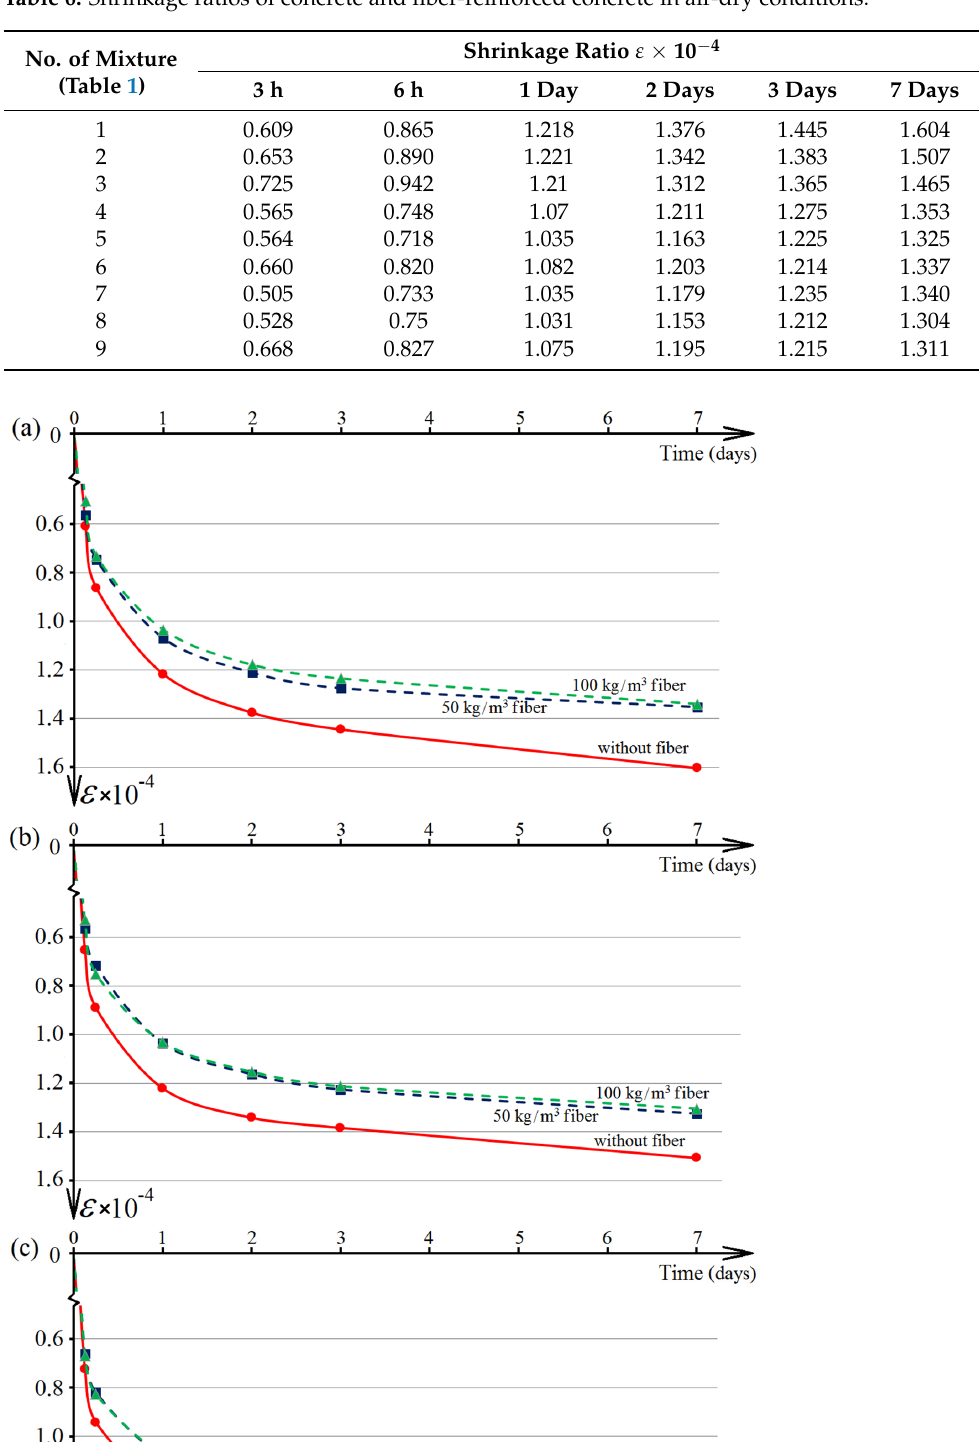
Table 6. Shrinkage ratios of concrete and fiber-reinforced concrete in air-dry conditions.